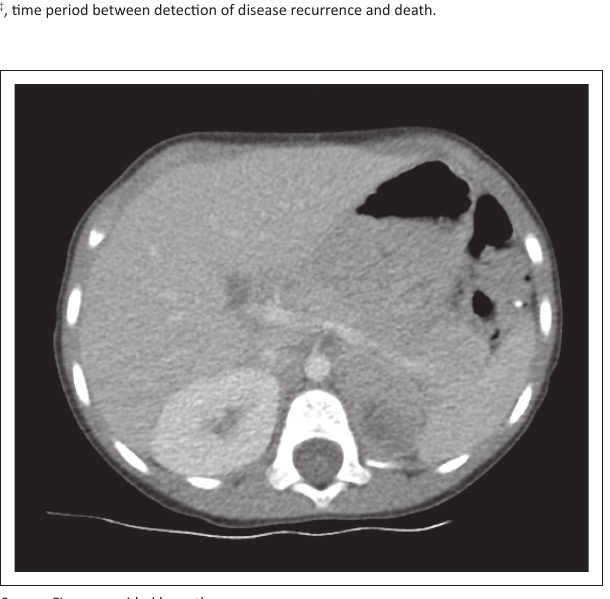
Source : Figure provided by authors. FIGURE 2: Surveillance abdominopelvic CT showing a soft-tissue density in the left kidney bed, not present on a previous follow-up scan, incorrectly interpreted as local recurrence of nephroblastoma. A follow-up CT, done one month later, confirmed this as unopacified small bowel. The patient was still in remission two years later.